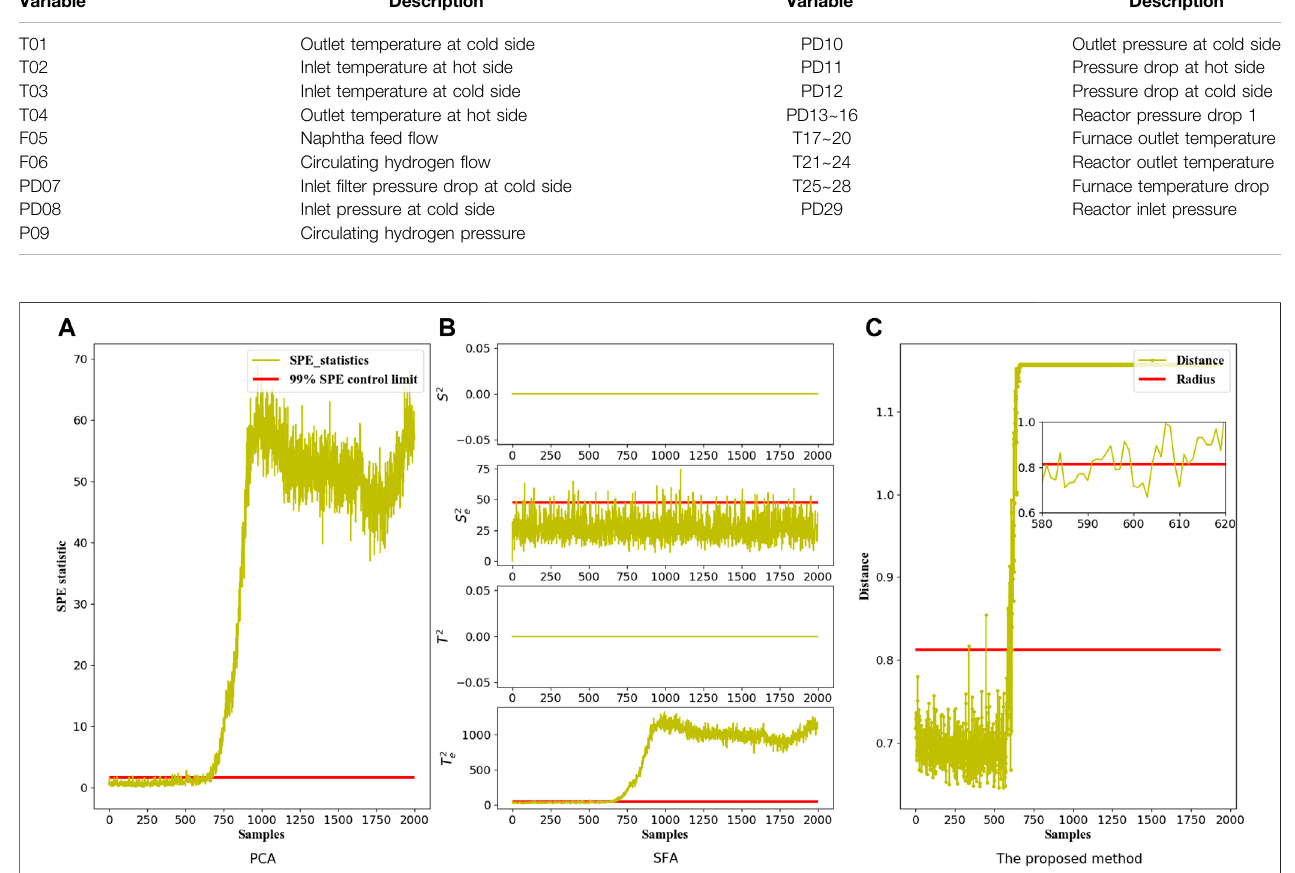
FIGURE7| Thefaultmonitoringgraphsoftheindustrialcontinuouscatalyticreformingheatexchangeunitcorrespondingtothreedifferentmodels: (A) PCAmodel, (B) SFA model and (C) The proposed multi-scale model.